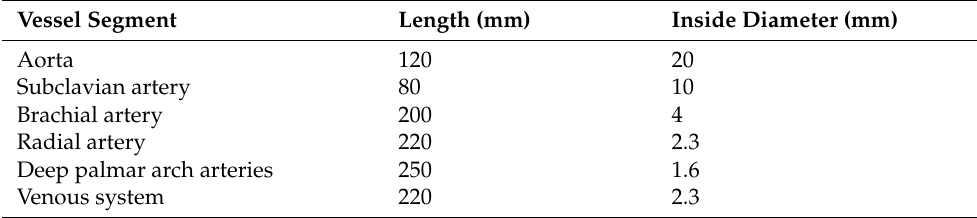
Figure 1. Diagram of the designed rig for the simulation of the upper-body circulatory system, which consists of a commercial pump that replicates the heart activity; aorta, subclavian, brachial, radial and deep-palmar arch arterial segments; a venous reservoir; and a single vein replicating the venous return. Pressure sensors were placed to measure the pressure of the fluid flowing through the system, and silicon, custom-made phantoms were used for the placement of photoplethysmography (PPG) sensors. Table 1. Characteristics of arterial and venous segments replicated on the in-vitro